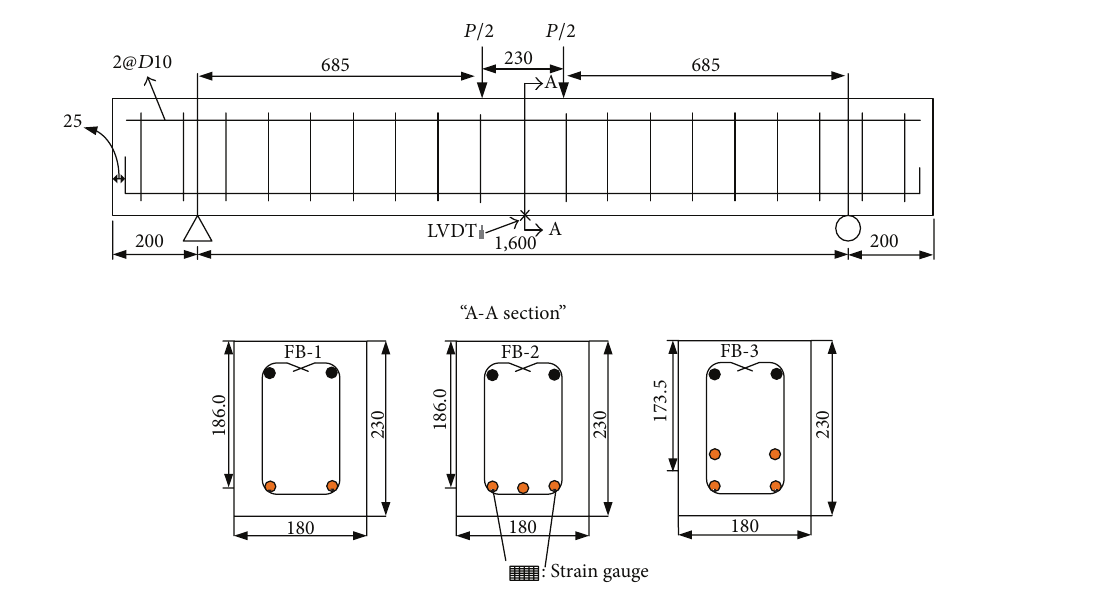
Figure 2: Test setup and measurement detail (in